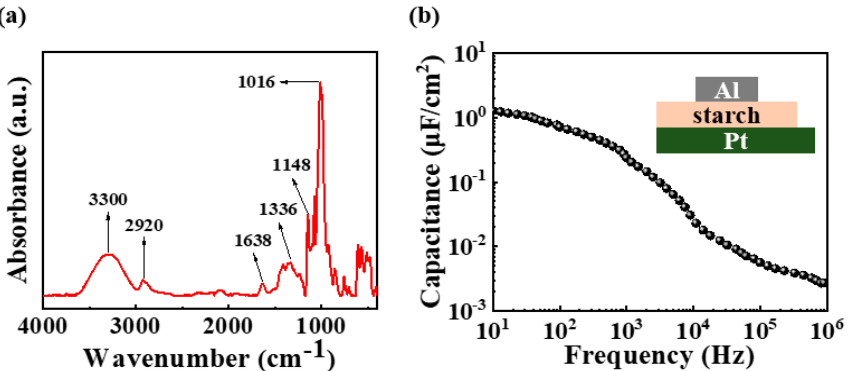
Figure 1. ( a ) FTIR spectrum of solid potato-starch electrolyte and ( b ) frequency-dependent capaci- tance of potato-starch electric double layer (EDL).